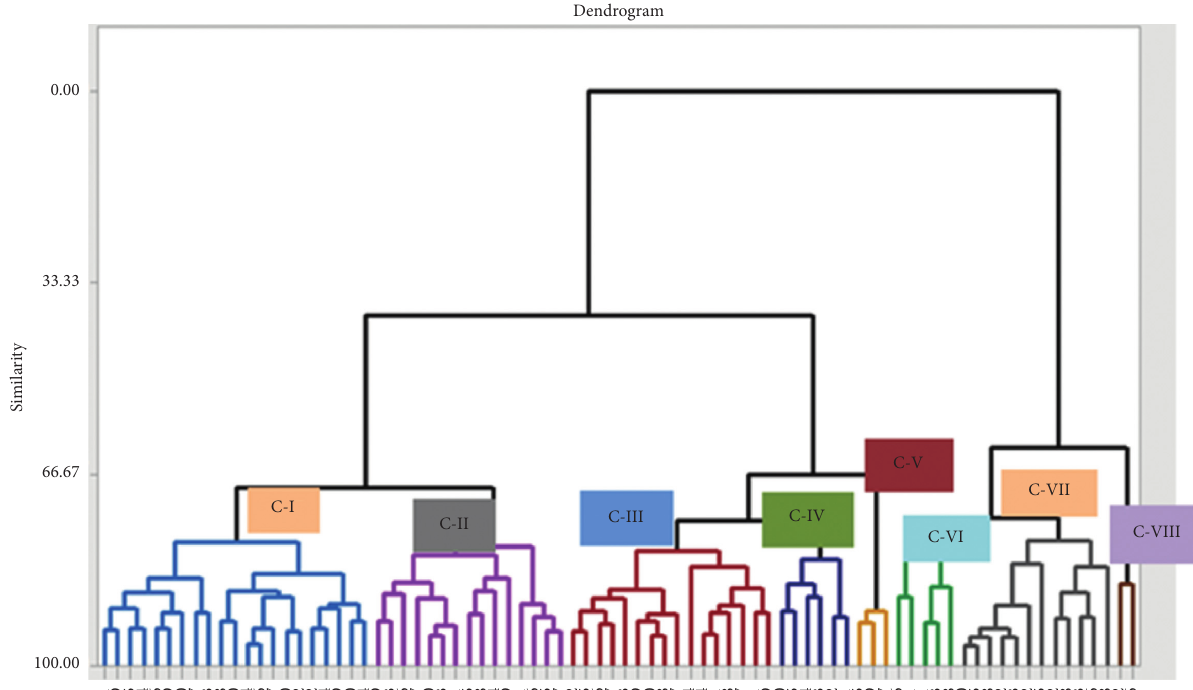
Figure 1: Dendrogram from cluster analysis of eighty accessions of Vernonia galamensis . Table 5: Mean values of 13 quantitative traits used in the clusters of 80 Vernonia galamensis accessions.